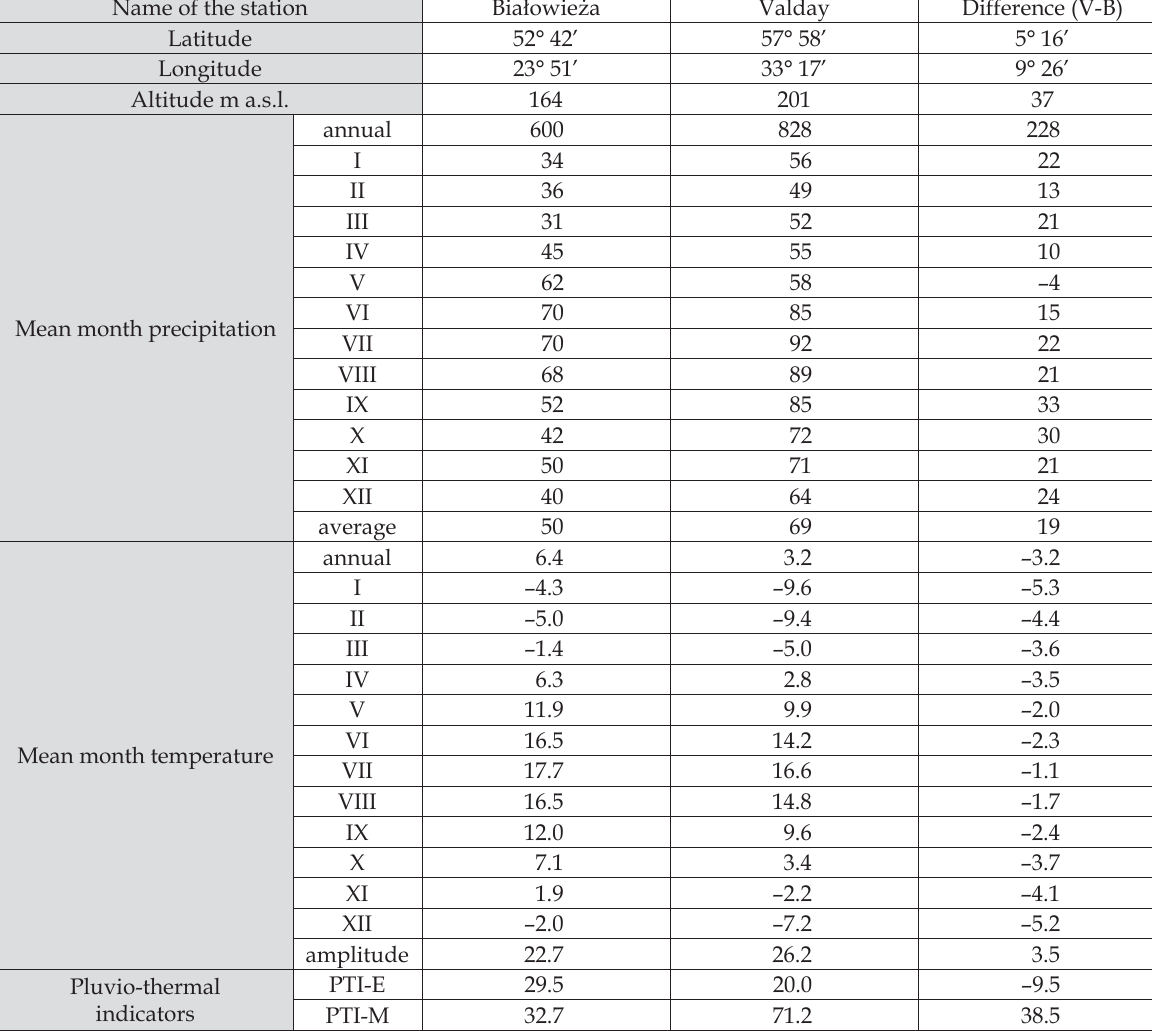
Table 2. The climatic conditions of the studied